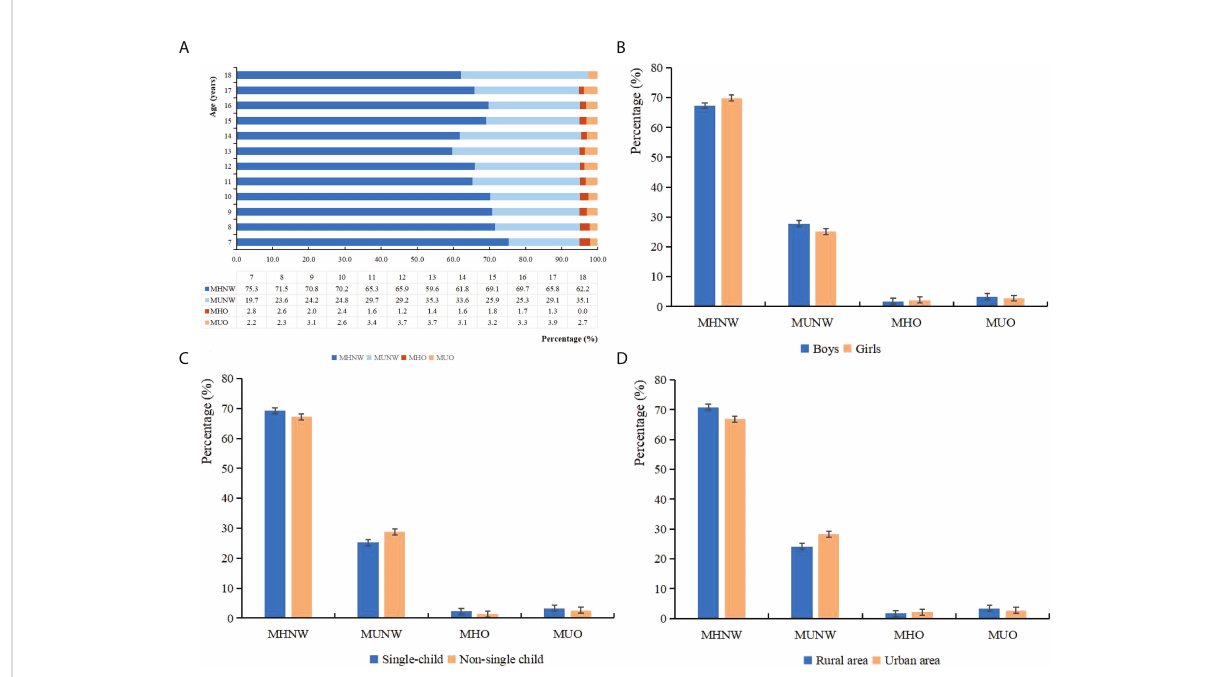
FIGURE 2 Percentage of different metabolic obesity phenotypes among each demographic group: (A) age, (B) sex, (C) single-child status, and (D) residence